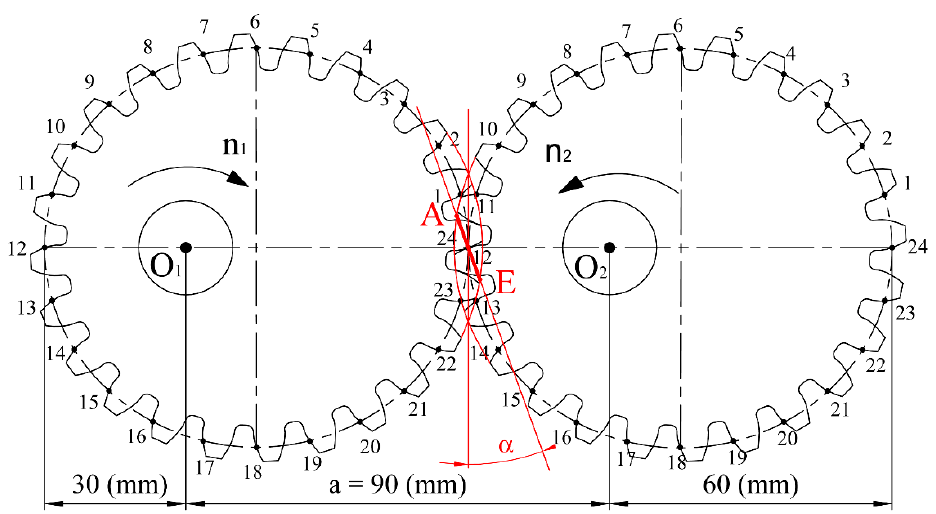
Figure 22. The length of part of contact.